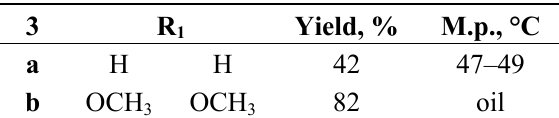
Table 1. Synthesis of amines 3